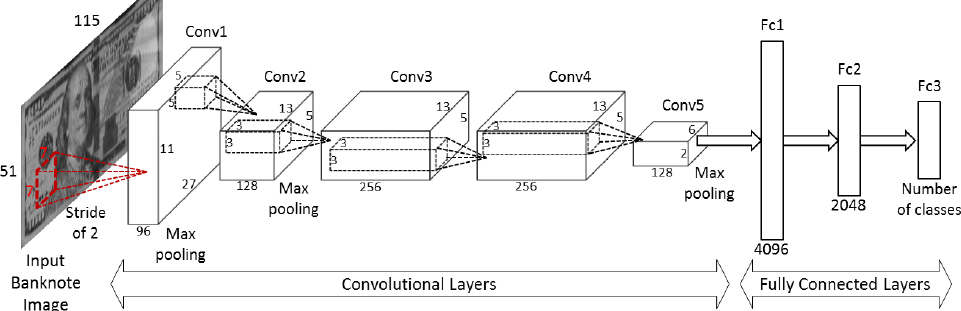
Figure 5. Architecture of the convolutional neural network (CNN).